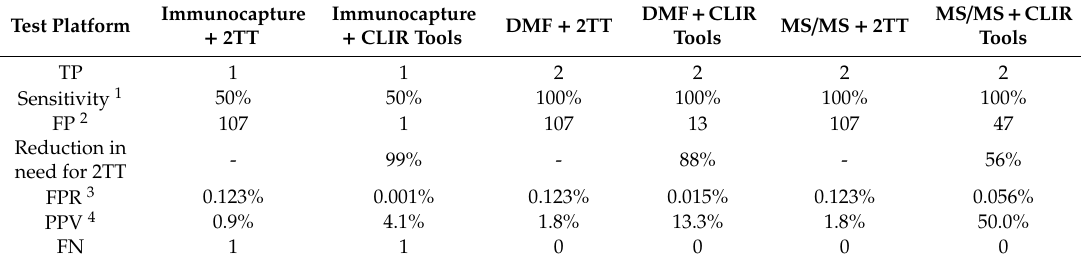
Table 5. Comparison of screening results without and with CLIR for Gaucher disease using di ff erent assay platforms and 2nd tier testing. The basis for this comparison is the population used for CLIR analysis ( n = 87,321) and shows that the application of CLIR reduces the need for 2nd tier tests and improves the screening performance.